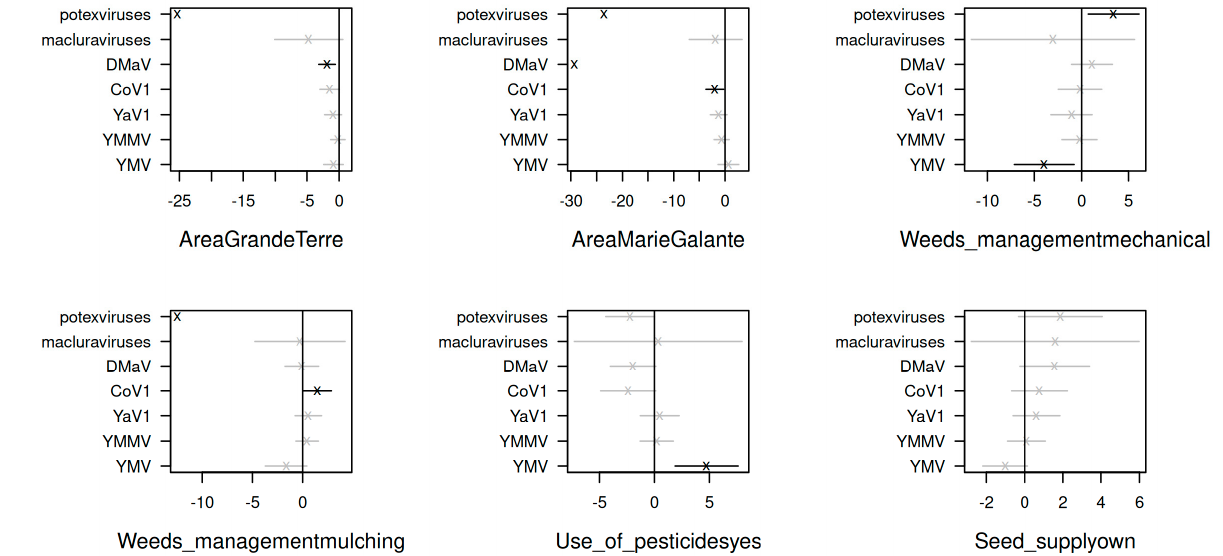
Figure 6. Plots of the coefficients (cross signs) and their standard errors (bars) from the gllvm analysis show the effects of crop-related variables on the standardised abundance of yam viruses in Guadeloupe. Significant and non-significant effects are shown in black and grey, respectively.